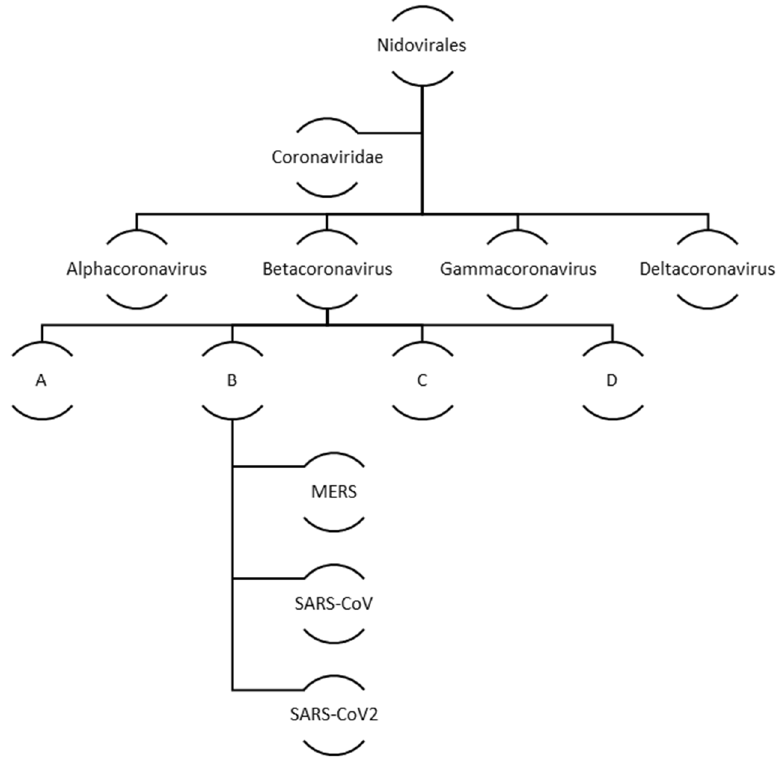
Figure 2. Evolution and classification of human coronavirus.